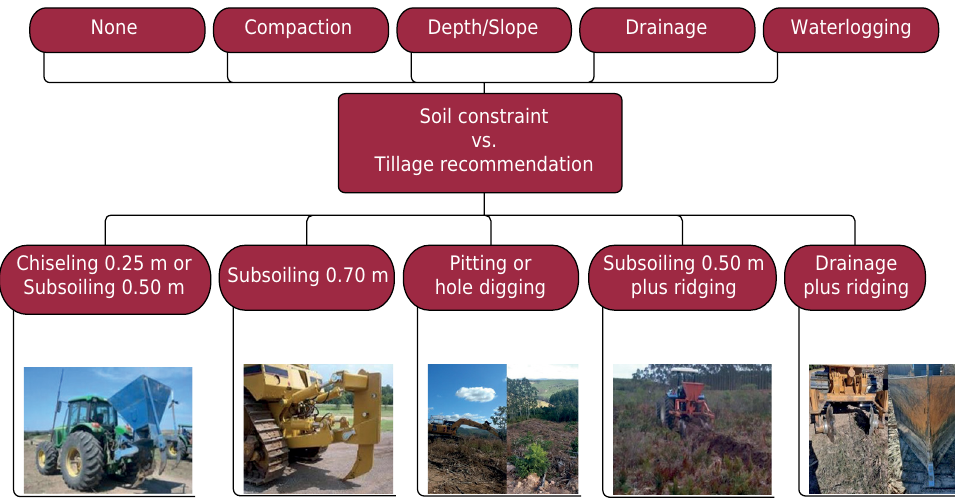
Figure 1. Soil tillage recommendation for soils with different physical constraints. Pictures taken by Elias Frank de Araújo.